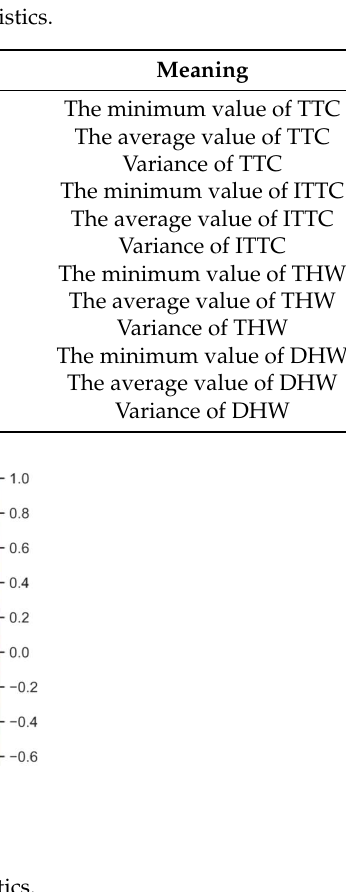
Figure 7. Correlation of driving style characteristics.